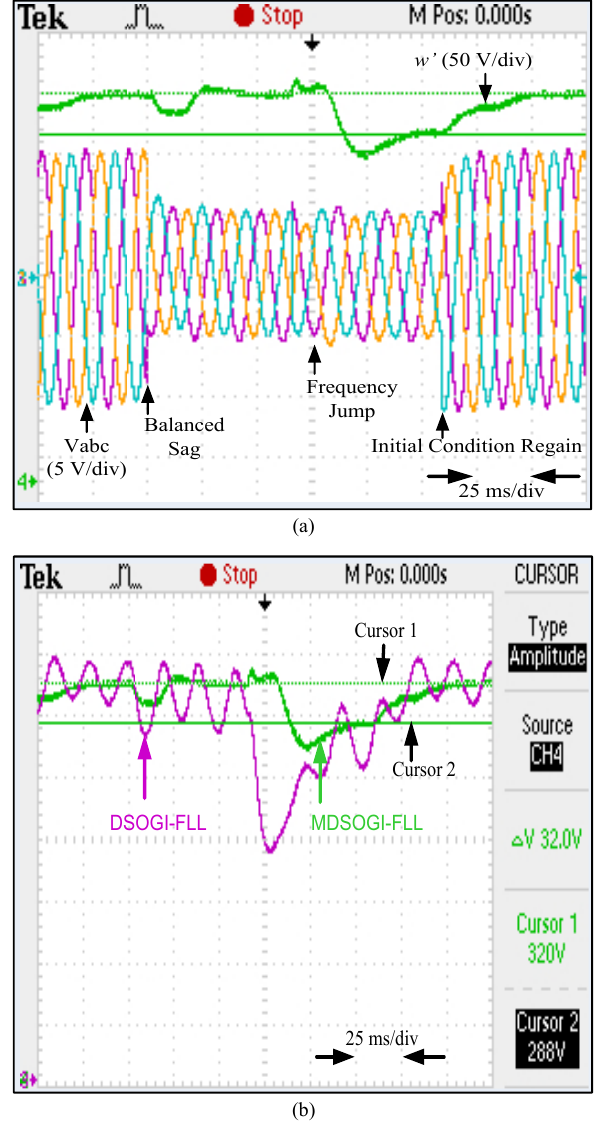
Fig. 9. Experimental results with balanced-sag and dc-offset in supply voltage: (a) Three-phase supply voltage signals (b) Estimated frequency with DSOGI-FLL and